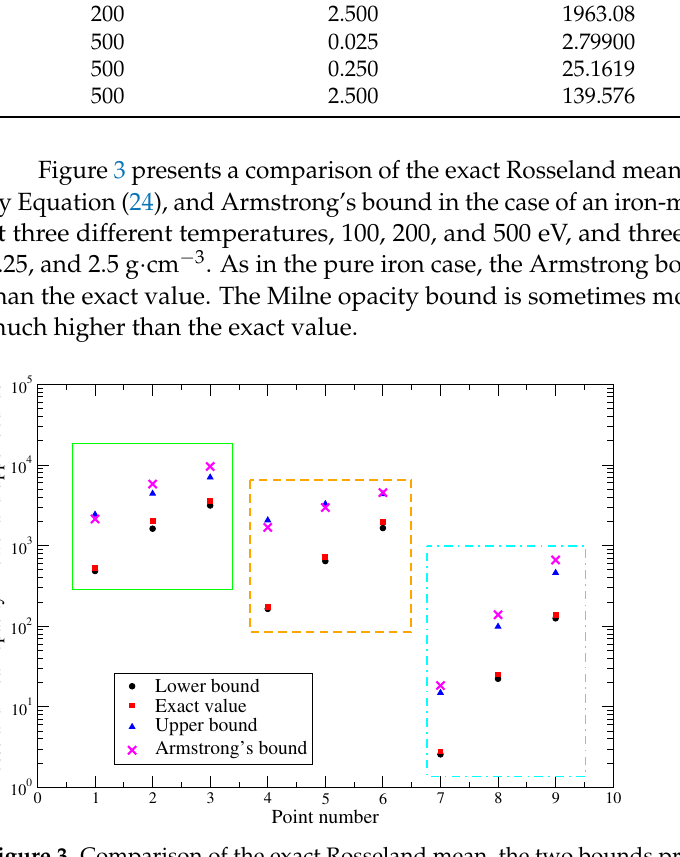
cm − 3 . Each rectangle · cm 3 , ·